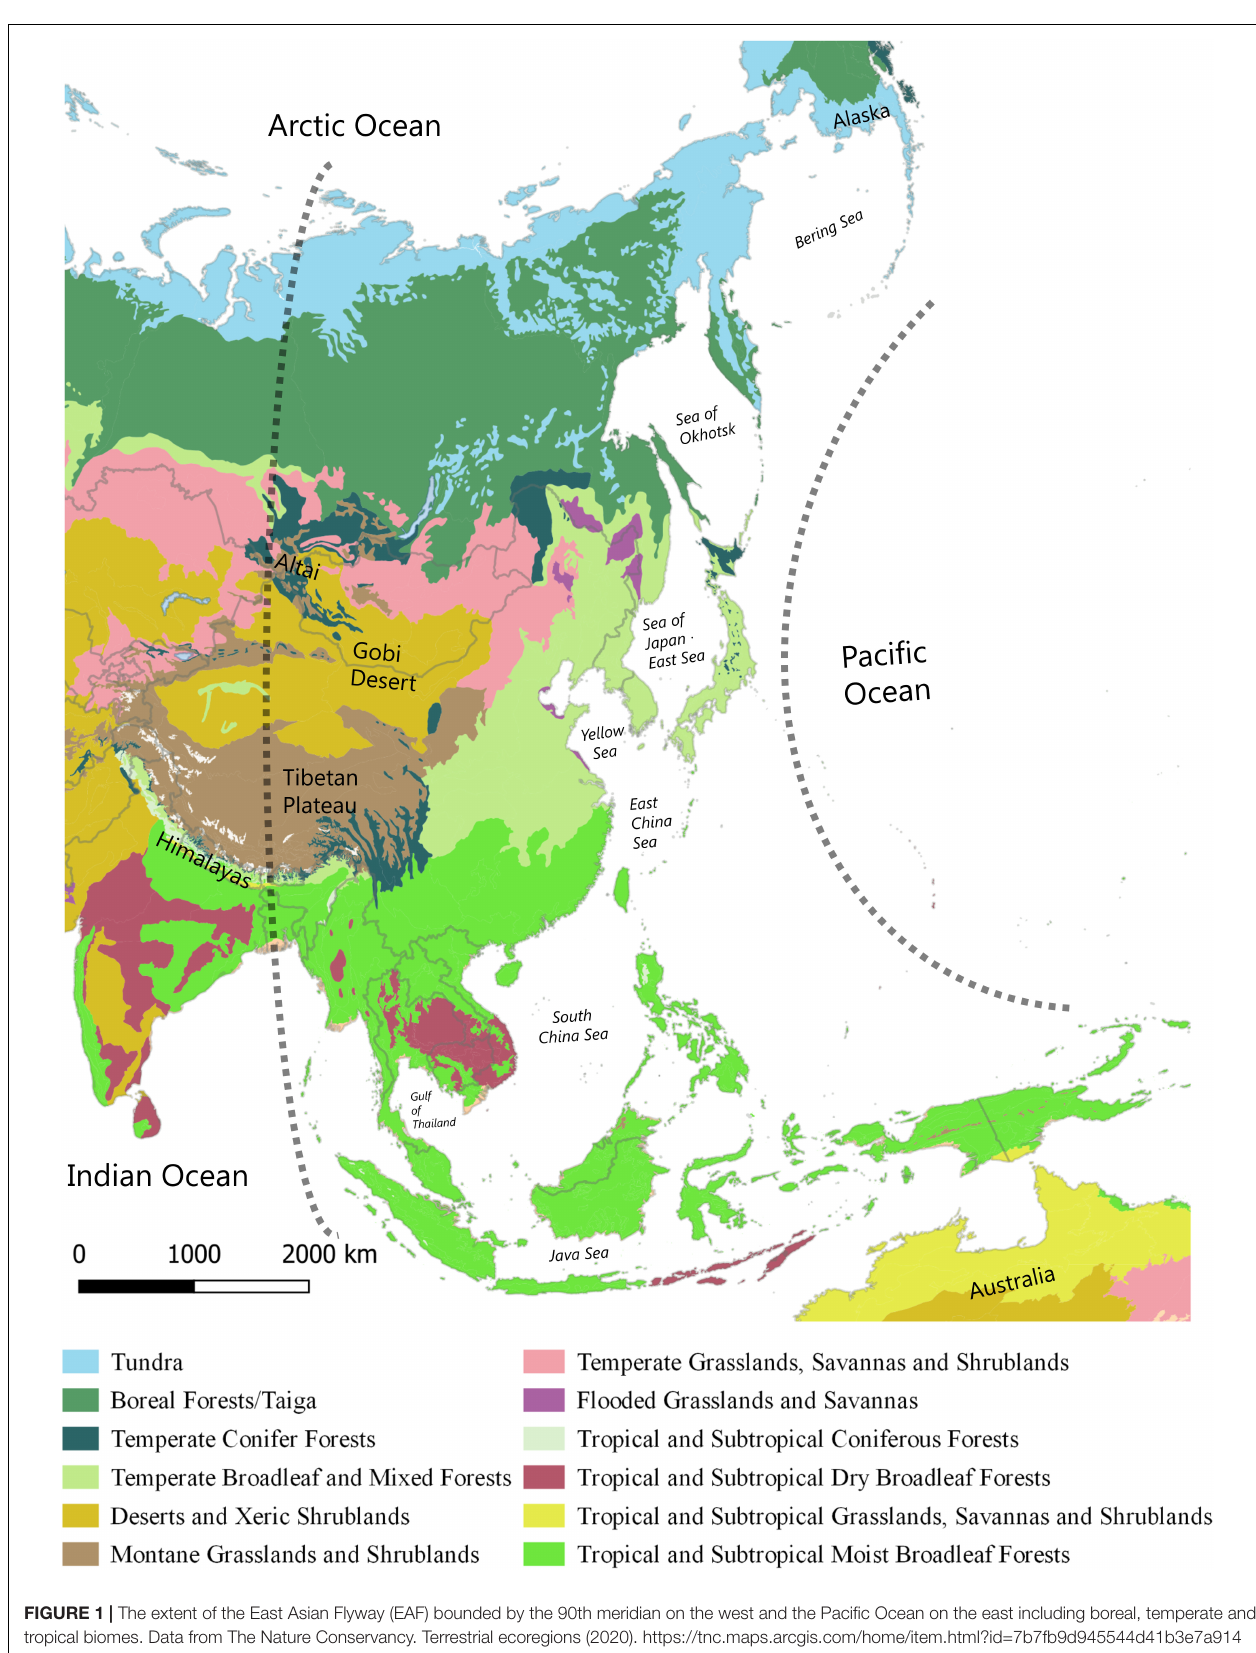
Frontiers in Ecology and Evolution |